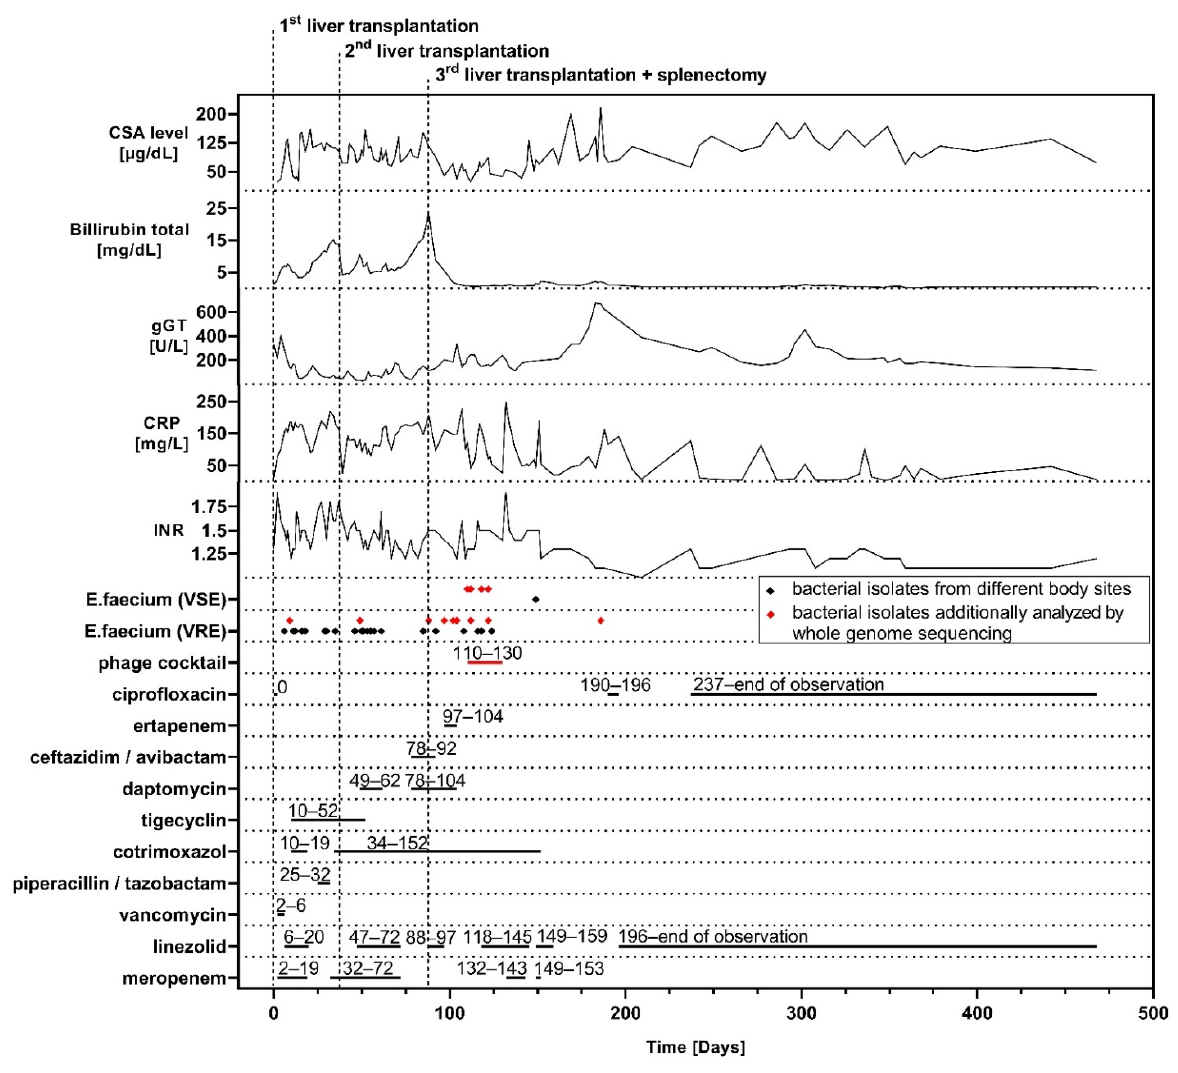
Figure 1. Time course of major operations, representative lab values, detection of vancomycin susceptible (VSE) and resistant (VRE) E. faecium from different sites as well as antibacterial treatment starting from the day of the first liver transplantation. Phages were administered over ten days of 2 mL/kg BW as a magistral preparation (joint titer first batch 8.1 × 10 7 PFU/mL in NaCl 0.9%) followed directly by another ten days of 2 mL/kg BW (joint titer second batch 5.2 × 10 8 PFU/mL in NaCl 0.9%) twice daily. Exact days of treatments, where the date of the first liver transplantation is defined as day 0, are plotted above each timeline, and isolates that were further analyzed by whole-genome sequencing are